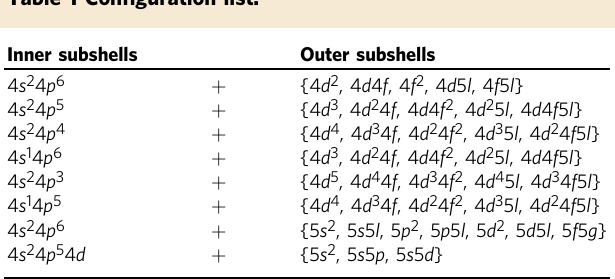
P P ð exp ð(cid:2) E = kT Þ ð 2 J þ 1 ÞÞ in i i J